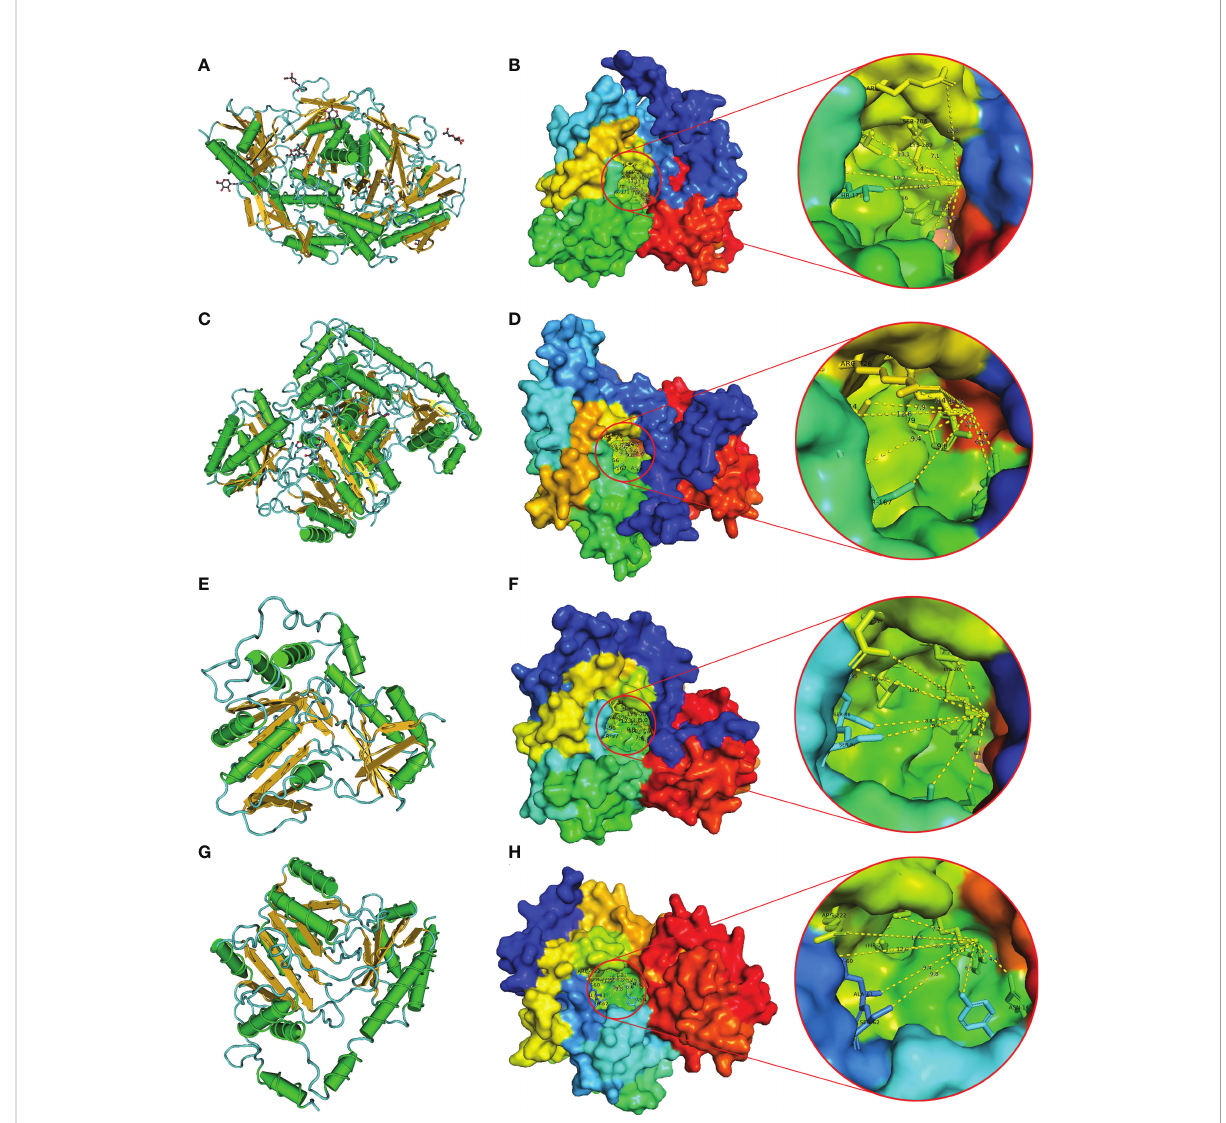
FIGURE 6 Predicted 3D structure of BnTAR genes. 2HOX and 3TCM were selected as examples. The models were predicted by Phyre2. Conserved domain analysis was highlighted using VAST. Red circles indicate the active center of the enzyme. (A) Predictive 3D structure of 2HOX in cylinder and plate mood. (B) The predicted 3D structure of 2HOX showed in the surface mood. (C) Predictive 3D structure of 3TCM in cylinder and plate mood. (D) The predicted 3D structure of 3TCM showed in the surface mood. (E) Predictive 3D structure of BnALL10 in cylinder and plate